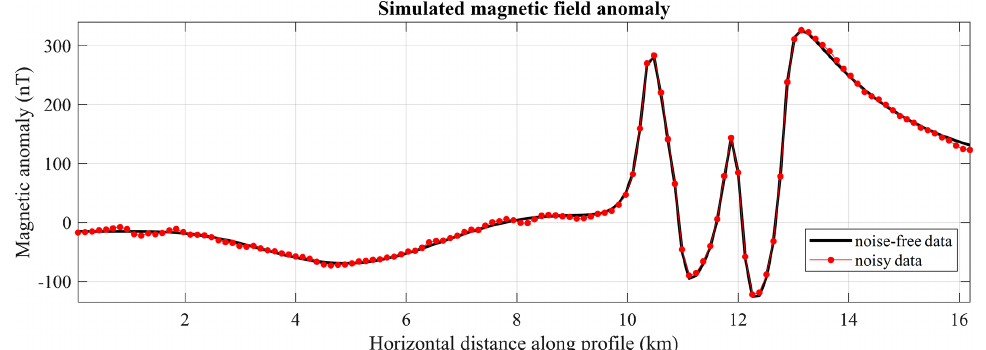
Figure 3. Simulated total magnetic field